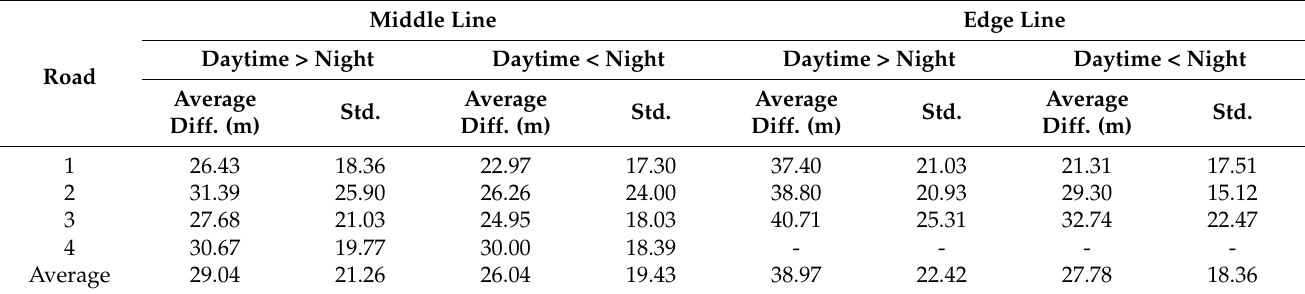
Table 6. Average differences in view range of middle and edge lines for each road and